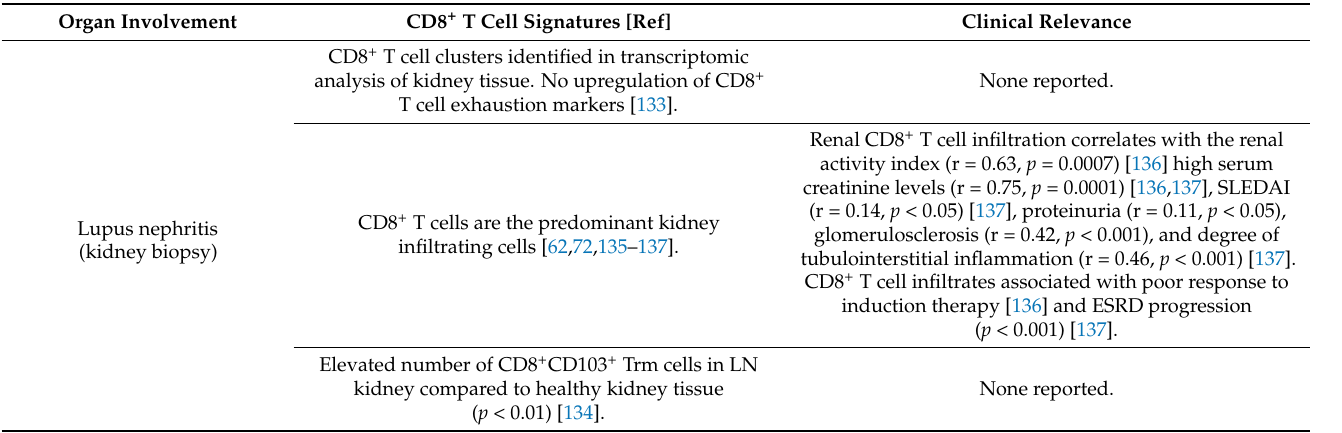
Table 6. Organ-specific CD8 + T cell profiles in